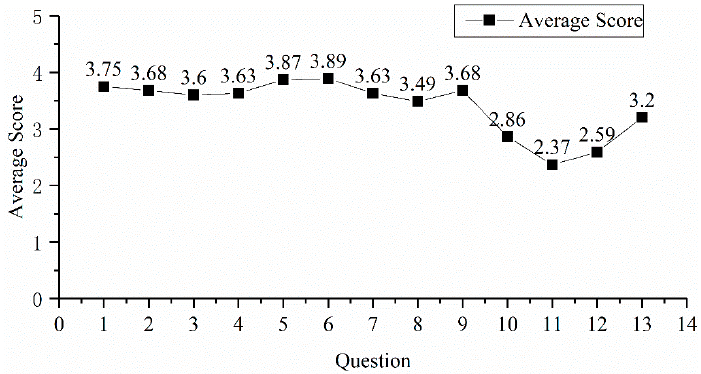
Figure 5. Average score of learners’ responses in the